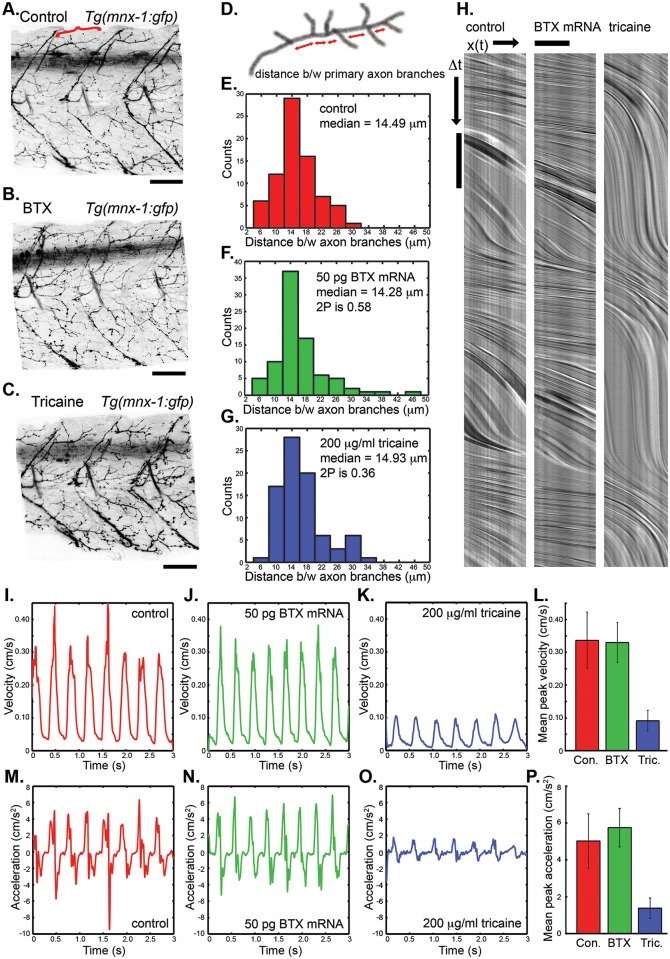
Prolonged immobilization with α-bungarotoxin mRNA does not grossly alter neural or cardiovascular development.
(A-C) 3D reconstructions of confocal images of 72 hpf Tg(mnx1:gfp) centered at the sixth somite reveal no gross abnormalities in motor neuron patterning or development when embryos are immobilized with 50 pg of α-bungarotoxin mRNA injected at the 1-cell stage (B) or 200 μg/ml of tricaine from 24 to 72 hpf (C) (scale bar 50 μm). A stereotyped axon (red bracket, A, schematic, D) was used to quantify axon branching. (E-G) The distributions of distances between axon branches were not significantly altered in embryos immobilized with 50 pg of α-bungarotoxin mRNA injected at the 1-cell stage (F, Mann-Whitney-Wilcoxon two tailed P-value 0.58) or 200 μg/ml of tricaine from 24 to 72 hpf (G, Mann-Whitney-Wilcoxon two tailed P-value 0.36). (H) Representative laser-scanning velocimetry results reveal no gross difference in cardiovascular performance between control embryos and embryos immobilized with 50 pg of α-bungarotoxin mRNA. 200 μg/ml of tricaine from 24 to 72 hpf does grossly alter blood flow. Vertical scale bar 100 ms, horizontal scale bar 20 μm. (I-P) Quantitative image analysis of laser-scanning velocimetry reveals no significant difference in cardiovascular function between control and α-bungarotoxin mRNA injected embryos while prolonged tricaine treatment significantly reduces peak blood velocity and peak blood acceleration (Mann-Whitney-Wilcoxon two tailed P-values < 1e-12, tricaine relative to control peak velocities, and <1.4e-11, tricaine relative to control peak accelerations).